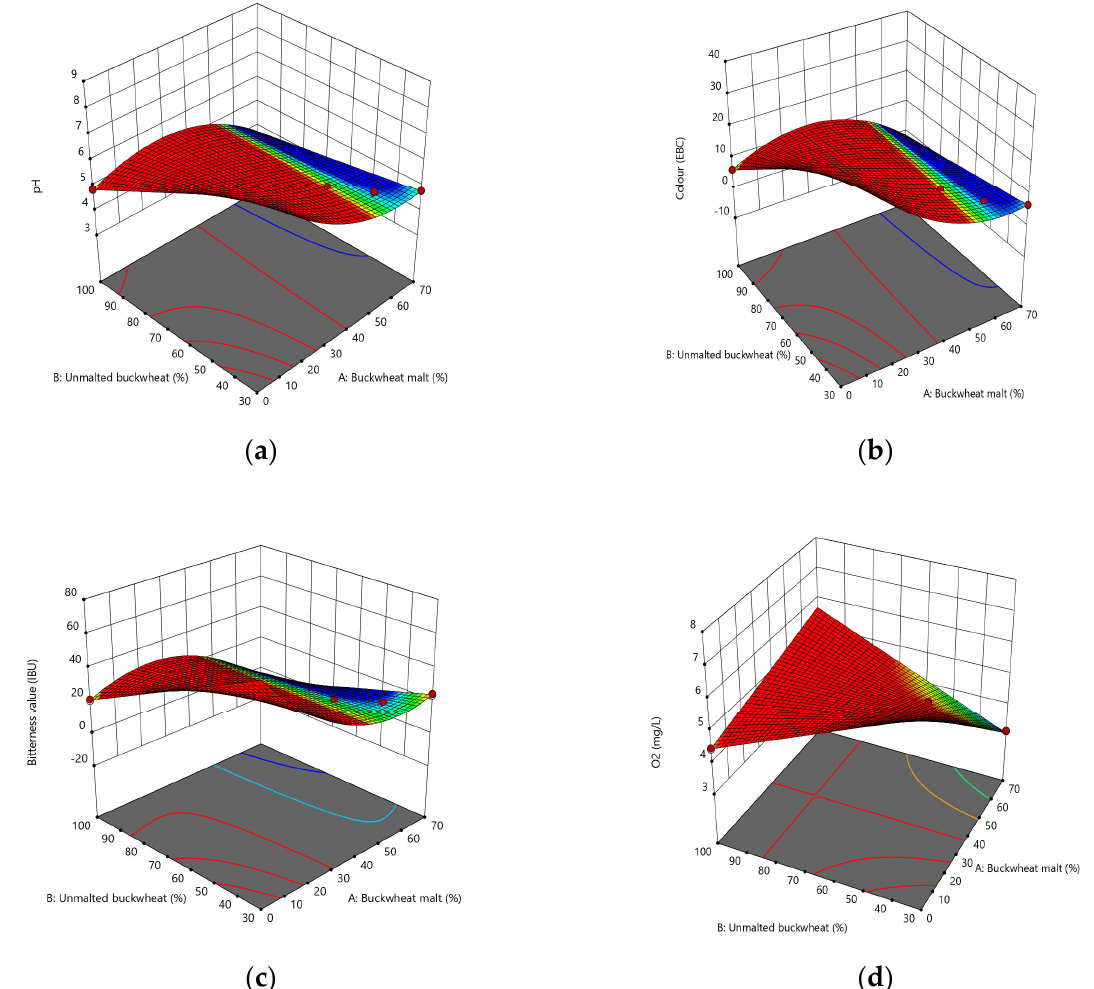
Figure 5. The graphical representations of the beer pH ( a ), color ( b ), bitterness ( c ), and oxygen ( d )